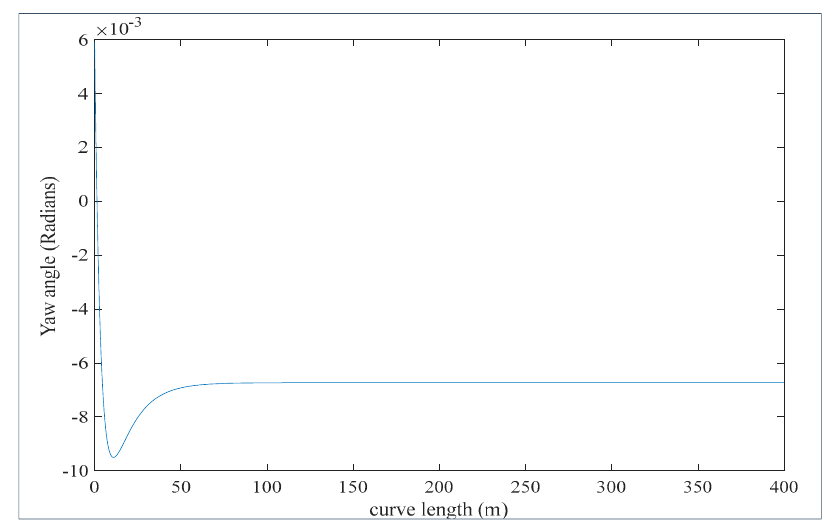
Figure 7. The yaw angle with respect to curve length.